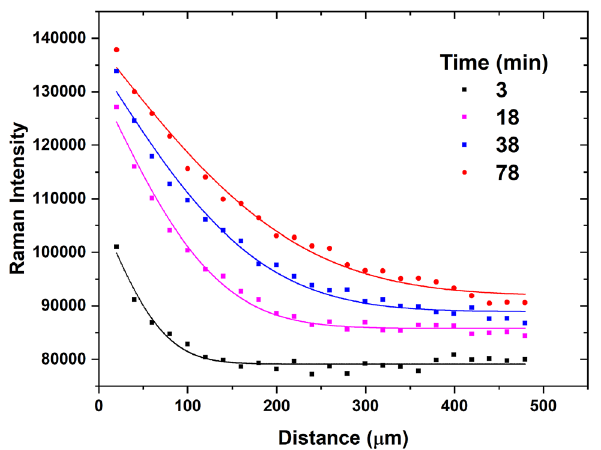
Fig. 3 Raman intensity versus distance away from the microfluidic channel shows the infiltration of mineral oil into PDMS. As a func- tion of time, the Raman signal increases indicating permeation of oil into the bulk polymer. The solid lines show theoretical values calculated through a one-dimensional Fickian diffusion